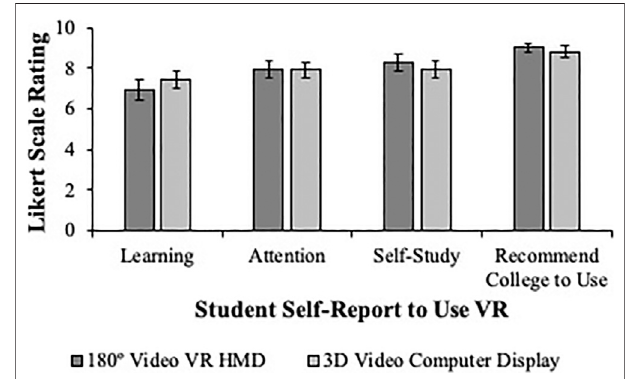
FIGURE6| Between-groupsparticipants ’ reportingoftheirdesiretouse theVRexperiencetoenhancetheirlearning.Thedatashowthatboththe180 ° video VR HMD (dark gray bars) and the 3D video computer display (light gray bars) experiences were reported with equally high ratings by participants, but they did not differ signi fi cantly from one another. However, the overall fi nding was that the students equally preferred the 180 ° video VR HMD and the 3D video computer display to increase their learning, attention, and self-study of the material, and they would recommend that their college/ university use such a pedagogical tool for their education. The data are illustrated as the mean ± SEM.